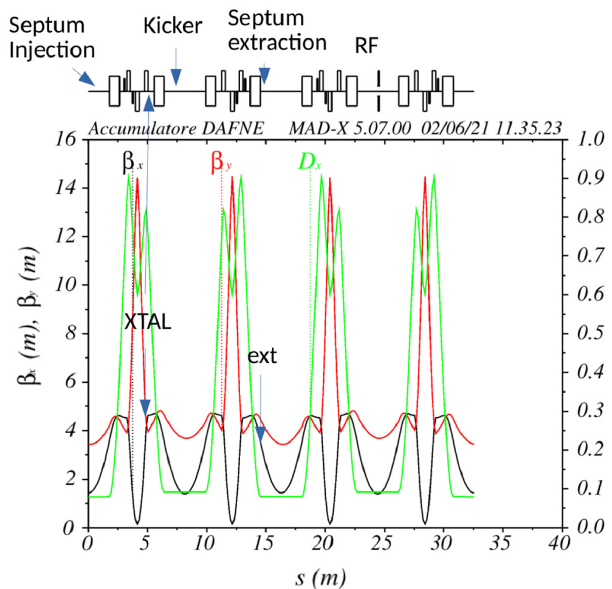
FIG. 4. H phase space plot at the extraction septum of particles injected with a +10 mm offset from beam pipe center and tracked for 18 turns. The extraction septum is represented by a red